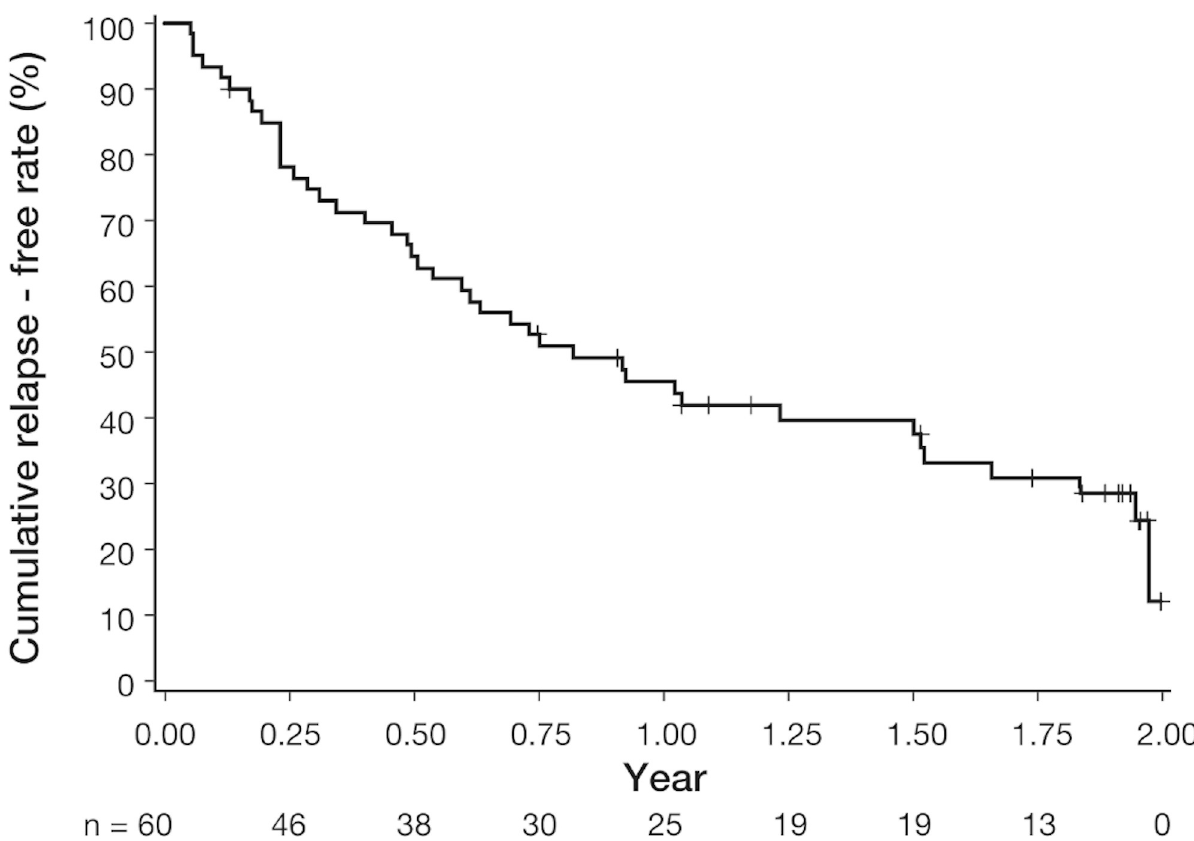
Fig 3. Kaplan–Meier plot for the relapse in patients with ulcerative colitis who achieved clinical remission and mucosal healing by treatment with budesonide foam for 6 weeks in the phase 2 or phase 3 clinical trials in Japan. The median survival time (year) without relapse was 0.82 (95% CI: 0.51 to